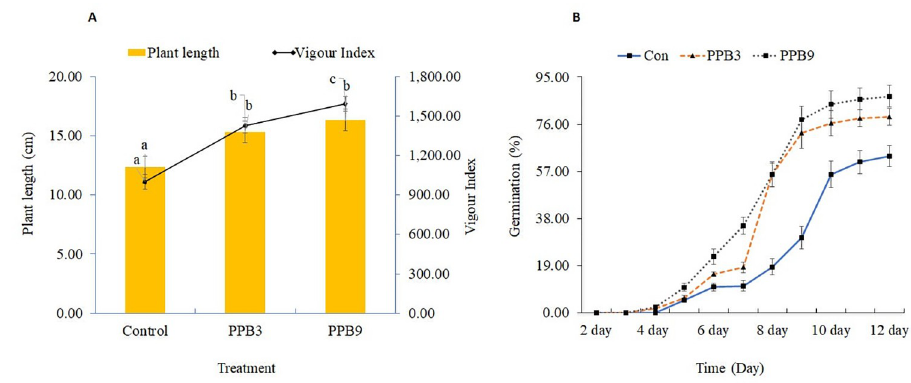
Fig 2. Effect of rhizobacteria on germination, seedling length and seedling vigour of tomato. Bacterial seed treatment was done by soaking seeds in the cell suspension of Stenotrophomonas maltophilia PPB3 (PPB3) and Bacillus subtilis PPB9 (PPB9). Seeds treated with sterile distilled water served as the non-bacterized control (Control). Bacterized and non-bacterized tomato seeds were placed on moistened filter paper in 9-cm Petri dishes. After seven days, the germination percentage, seedling length and vigour (vigour index = % germination × total plant length) were recorded (A). Bacterized and non-bacterized tomato seeds were evaluated for germination in a pot experiment. Fifteen pots (11.50 cm × 15.0 cm) filled with sterilized soils were prepared for each treatment, and each was sown with five seeds. Pots were placed in a growth room at 24˚C temperature and a 16/8 h photoperiod. Germination was recorded daily for 12 days (B). Values are means ± standard errors. Fisher LSD test ( P < 0.0 5 ) was done to indicate significant differences among